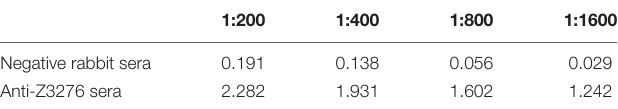
TABLE 4 | Z3276 expression in vitro using indirect ELISA.